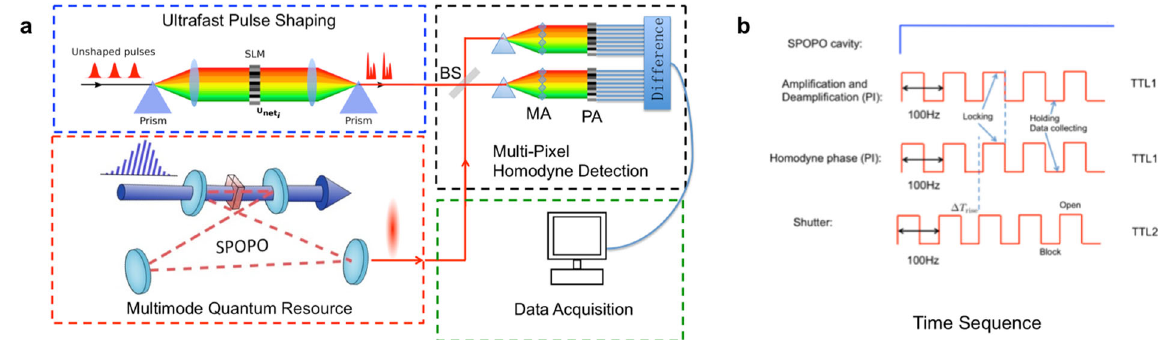
Fig. 6 Simultaneous measurement regime with multi-pixel Homodyne detection. a The multimode quantum resource is generated via a synchronously pumping an optical parametric oscillator (SPOPO). The local beam of homodyne detection could apply pulse shaping technique to access on-demand pulse shapes, which is not yet used for constructing covariance matrix. The two beams, going through a balanced beam splitter (BS), are dispersed by a pair of dispersive optics, and each color injects on the corresponding pixel of the the photodiode array (PA). To eliminate the loss induced by the gaps between the pixels of PA, a pair of micro-lens arrays (MA) is set in front of the PA. b Time sequence for locking and data